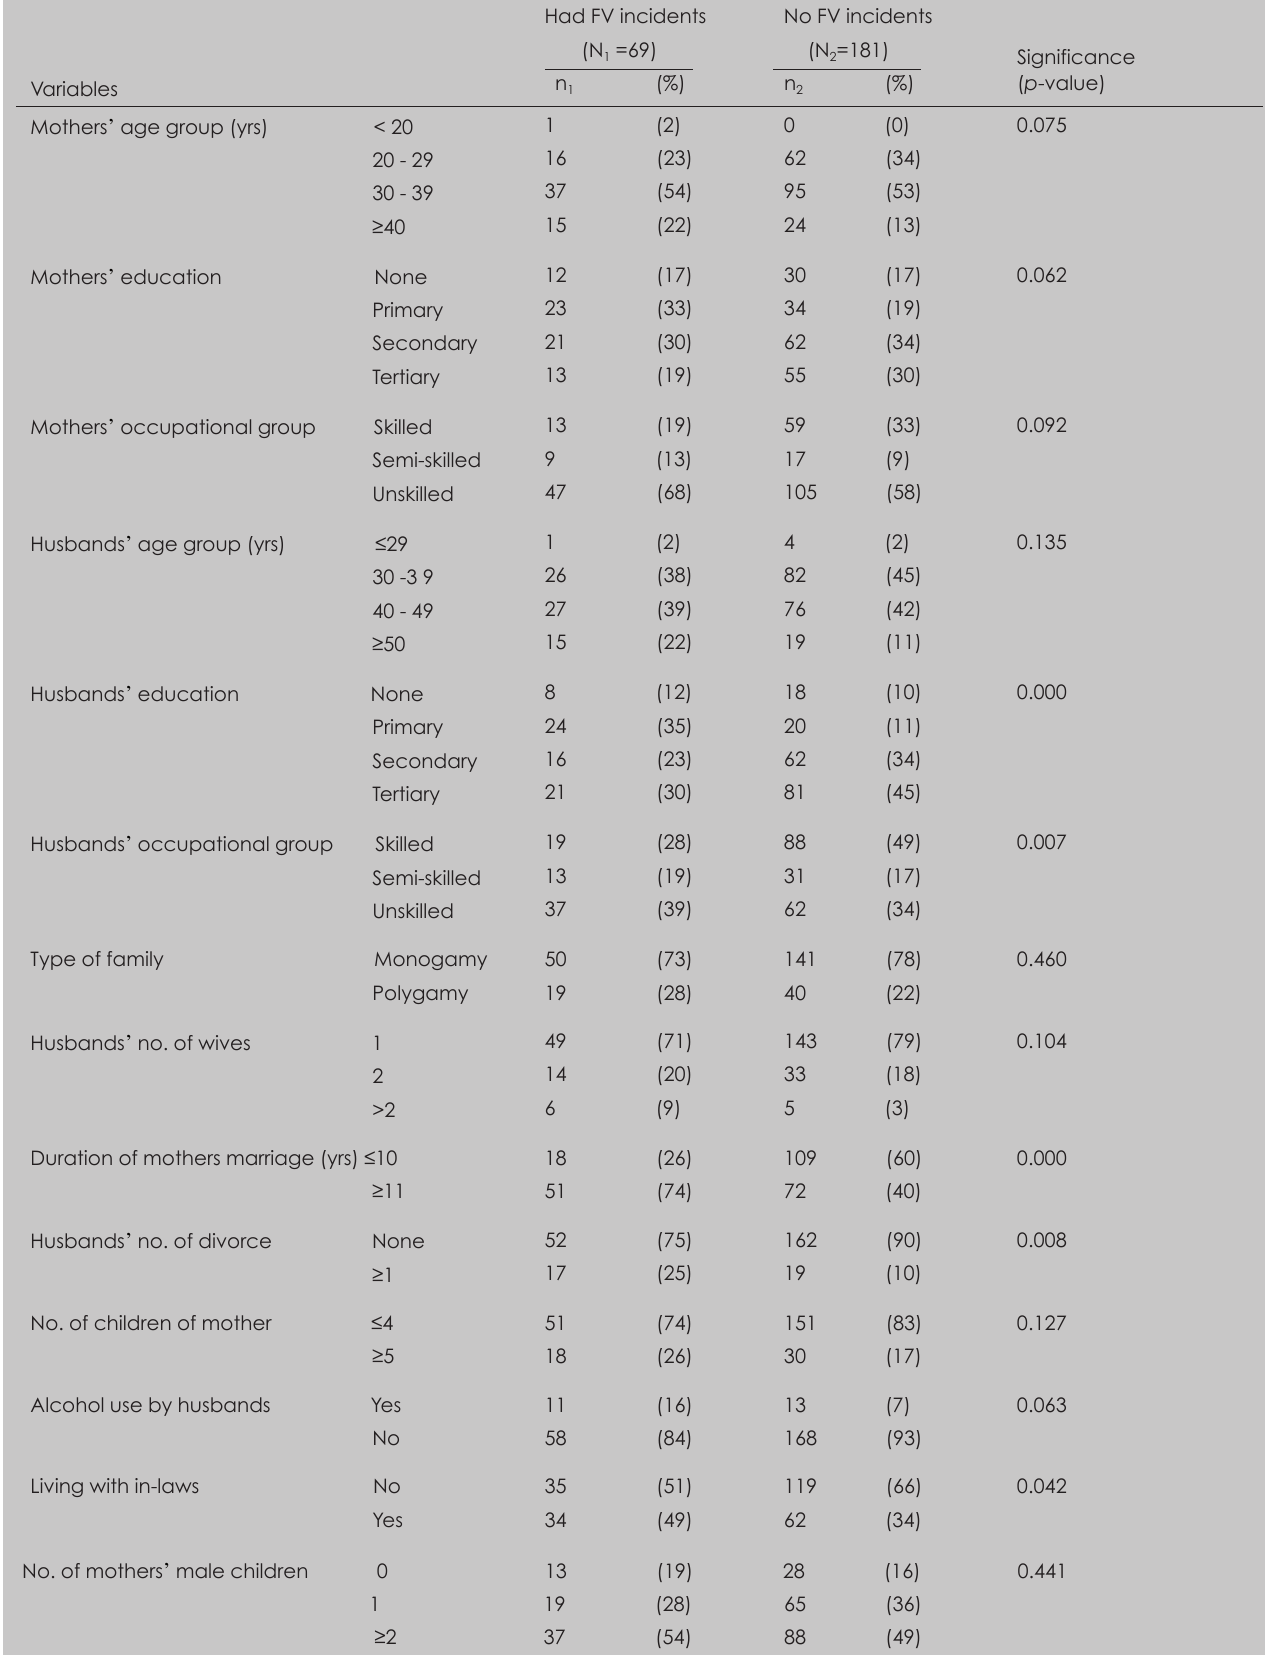
Table I. Sociodemographics, family characteristics of the mothers and correlates of FV